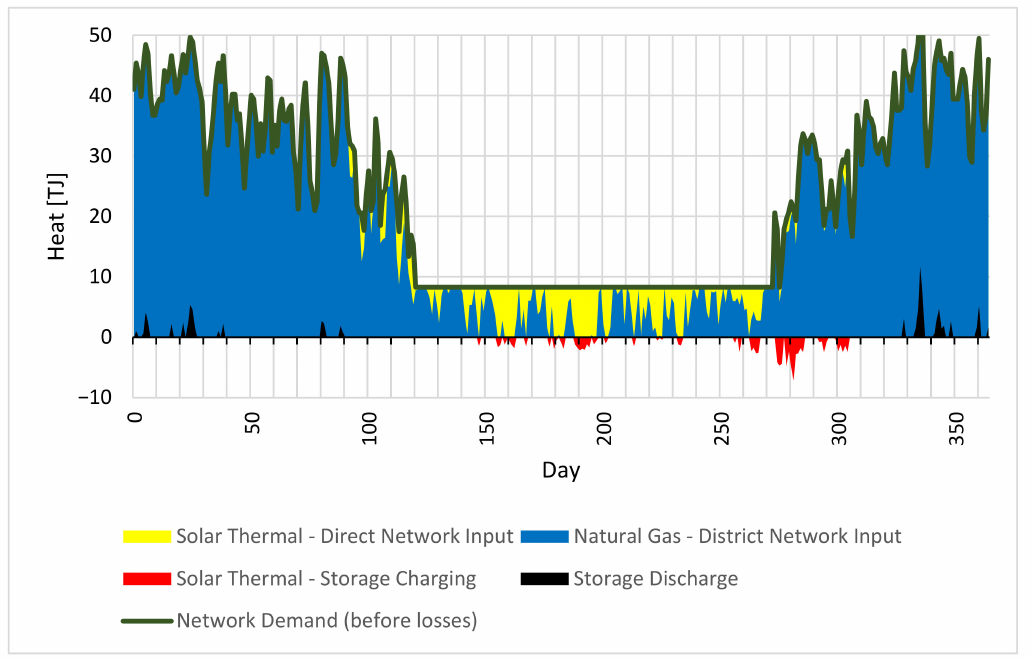
Figure 3. Daily heat flows in the system for the STAT scenario with the share of heat production from solar heating plants at least at the level of 10%.